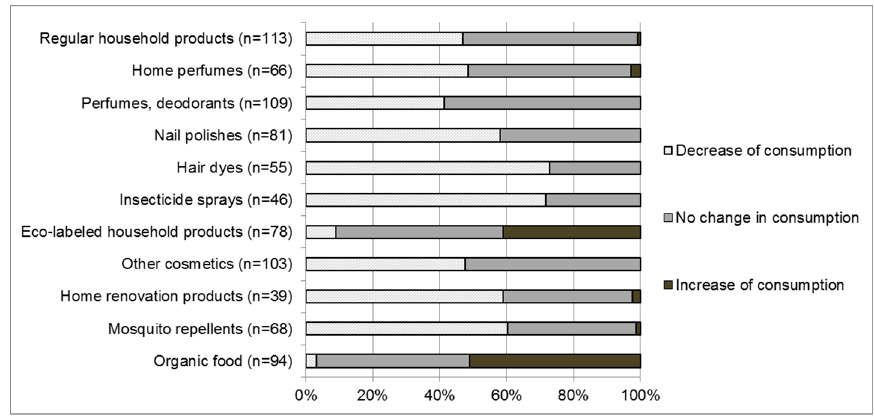
Figure 4. Change in consumption habits among women who use a range of common products ( n = 121).